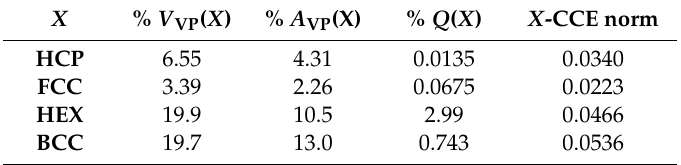
Table 7. Relative percentage di ff erence between the computer-generated local structures with very high crystal similarity (as visualized in Figure 8) and the reference, perfect 3-D crystals with respect to volume, surface area and standard isoperimetric quotient of the enclosing Voronoi polyhedron. Also reported in the last column is the corresponding X -CCE norm for the computer-generated